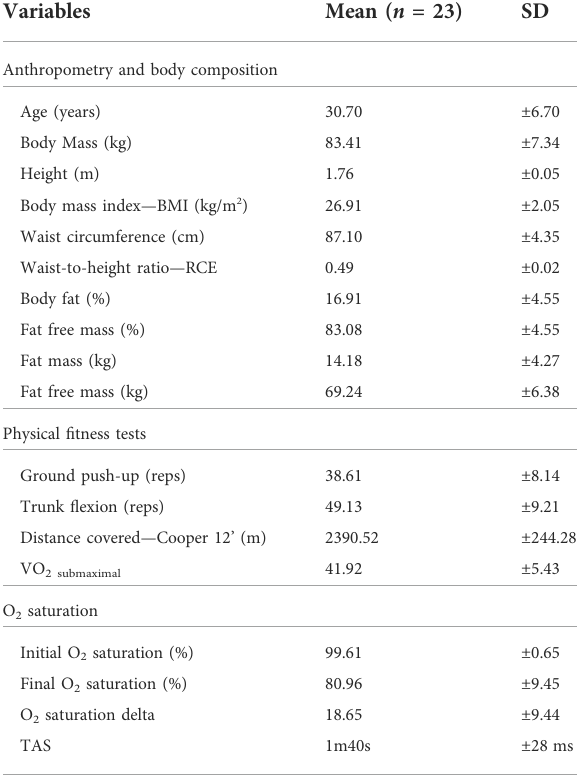
TABLE 1 Sample characterization and physical assessment